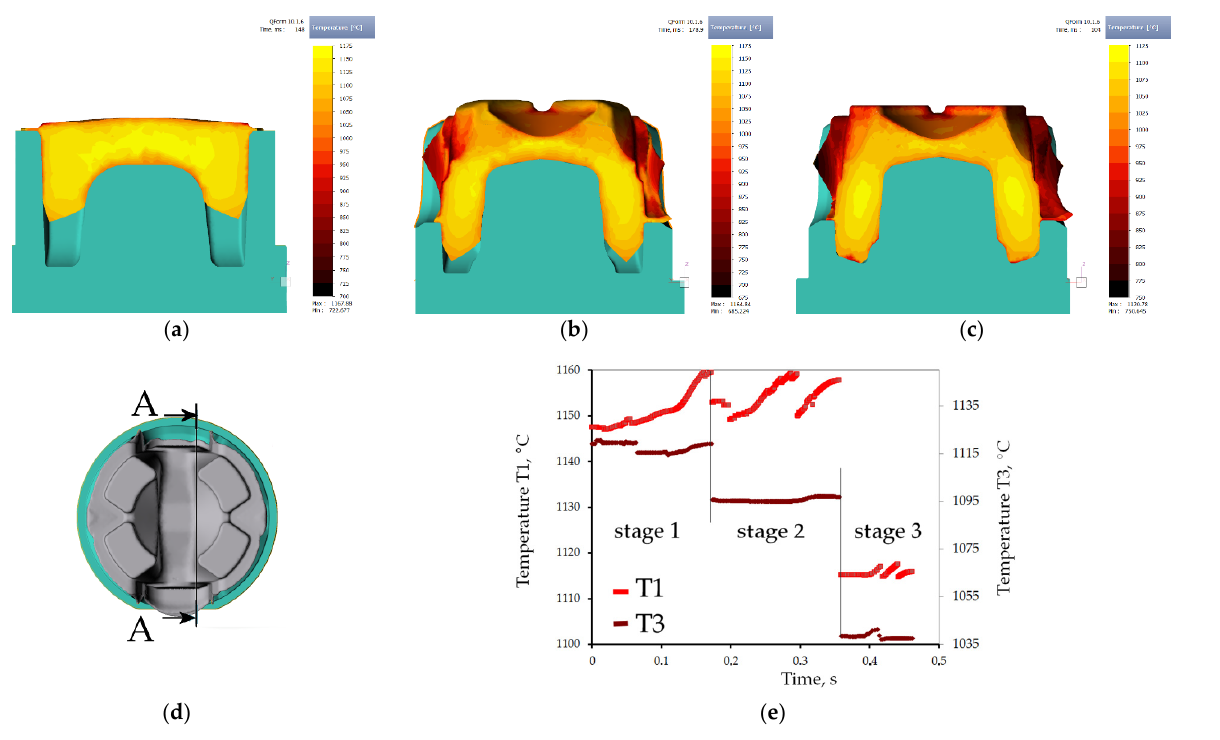
Figure 12. Results of FEM modeling: ( a – c ) temperature distribution on the cross-section A-A, ( d ) location of cross-section A-A, ( e ) history of temperature changes during forging chain (excluding feedstock transfer removed for clarity) in locations of thermocouples T1 and T3 (see Figure 1b).